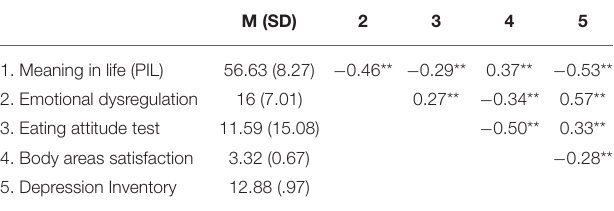
TABLE 2 | Mean and zero-order correlations for the variables in young